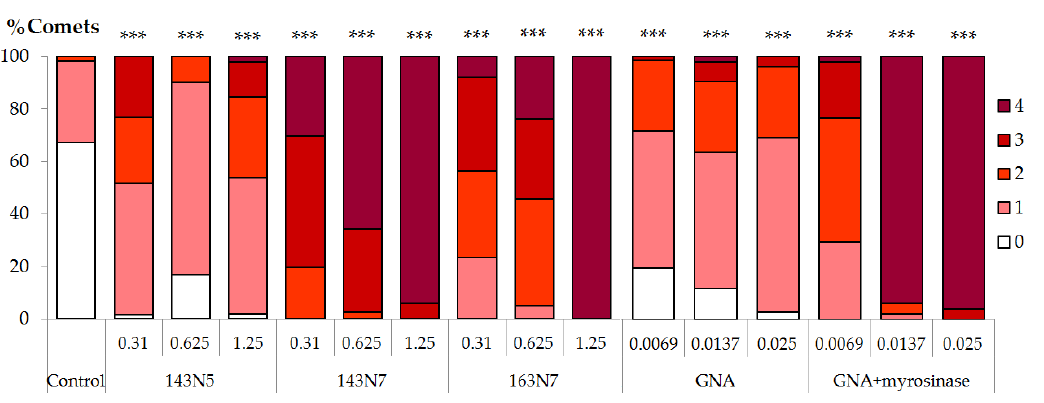
Figure 6. Comet distribution into visual scoring categories in HL-60 cells treated with increasing concentrations of B. rapa , gluconapin and hydrolyzed gluconapin samples (mg/mL). Categories are shown using a red colour scale from white (category 0) to deep red (category 4). *** Significance levels with respect to control ( p ≤ 0.001).